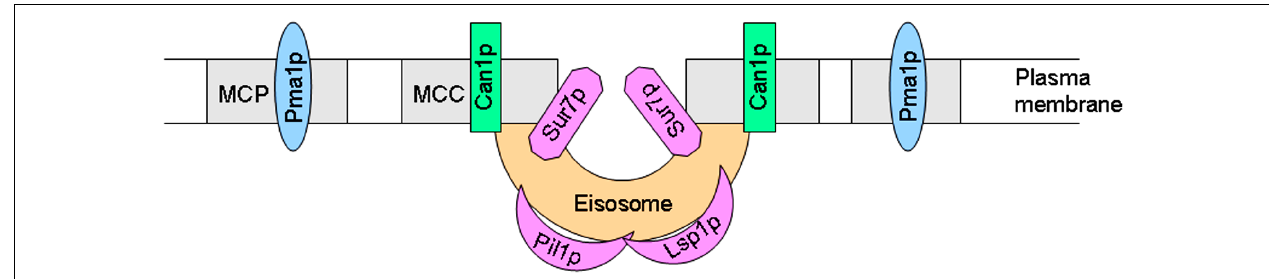
FIGURE 3 | Schematic view of yeast MCP, MCC, and eisosome membrane subdomains.